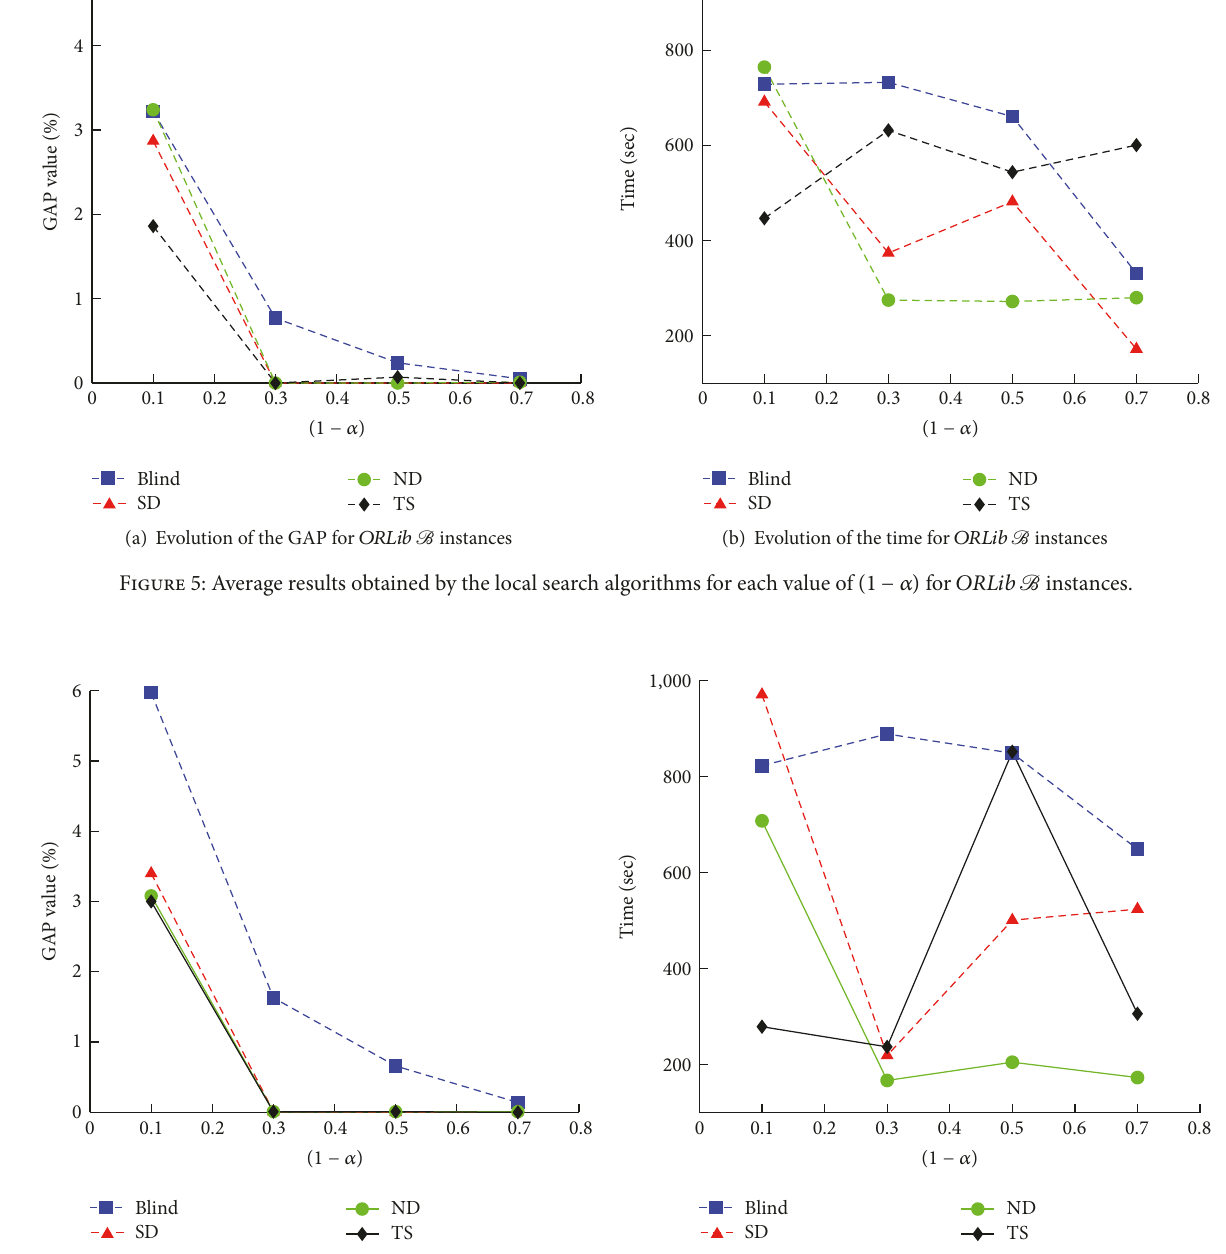
of facilities randomly so the problem has a feasible